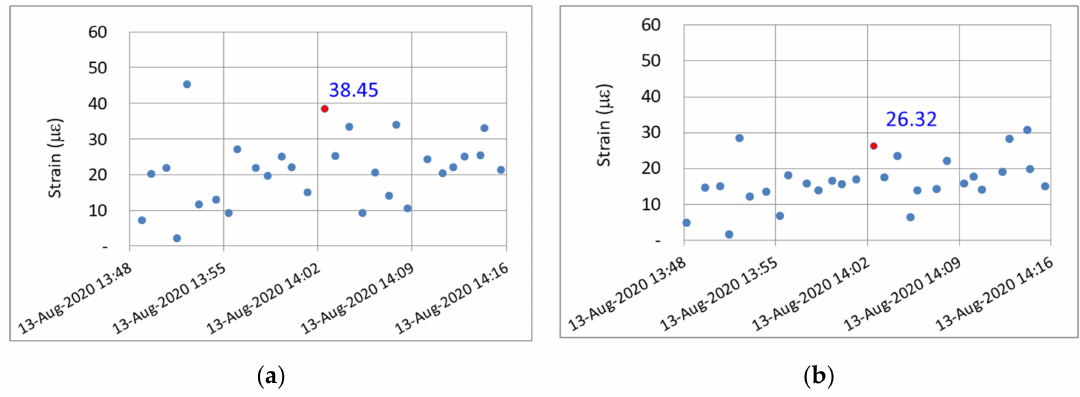
Figure 17. Vehicle loading test: strain responses of the ( a ) fifth and ( b ) seventh spans.